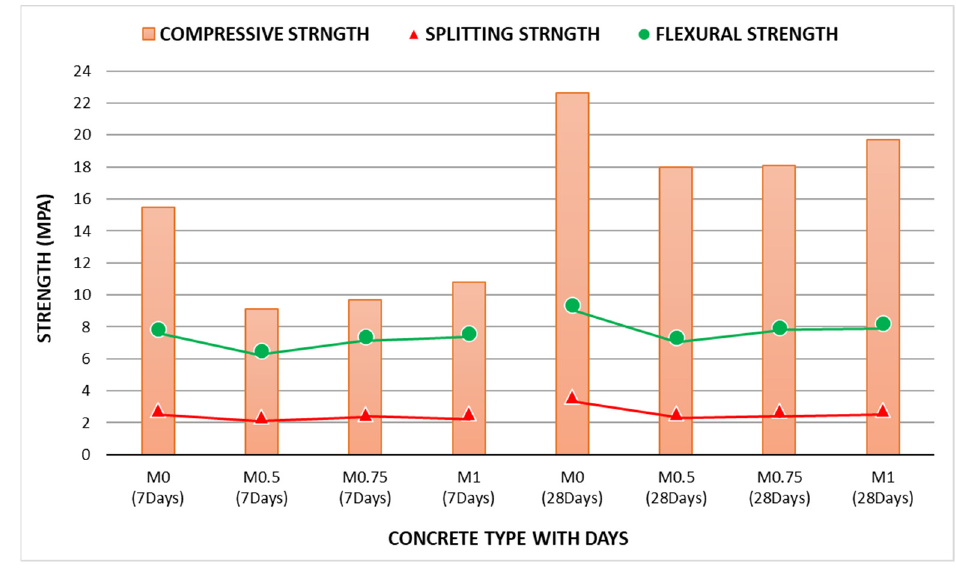
Figure 18. The mechanical properties of several SCC mixes comparison at 7 and 28 days.